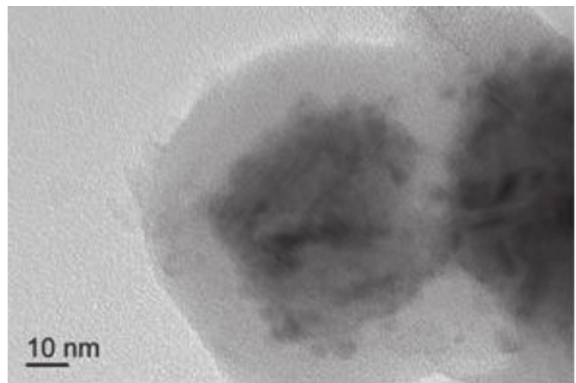
Ni com- 27.5 72.5